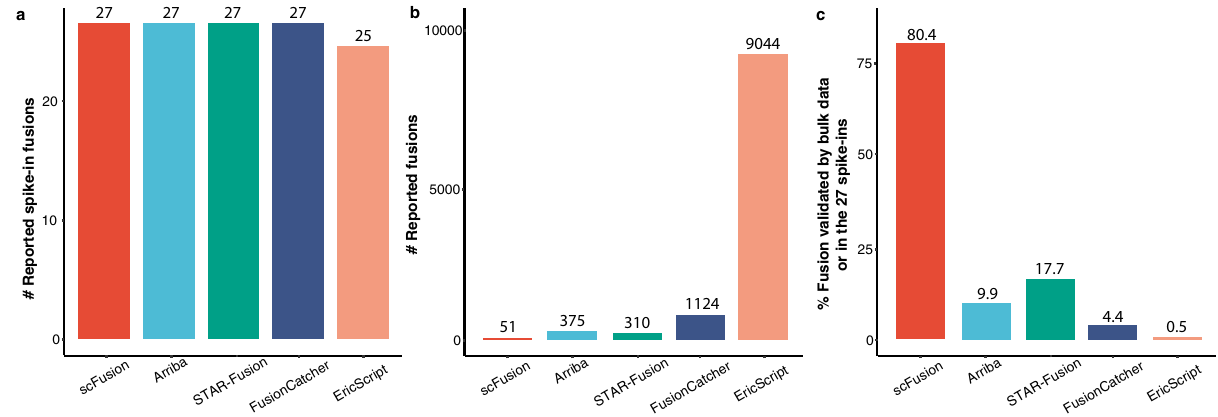
Fig. 5 The performance of fi ve methods on spike-in data. a The numbers of reported spike-in fusions. b The numbers of reported fusions. c The proportions of fusions having bulk supporting chimeric reads or in the 27 scFusion (Fig. 7f) and potentially many more false positives (Fig. 7a, b). The large number of false positives given by the bulk methods makes it very dif fi cult for downstream analysis, thus limiting their application in single-cell analysis.